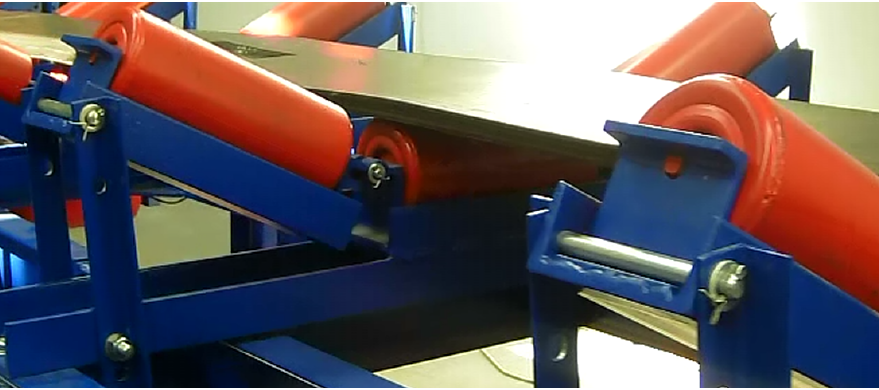
Figure 22. A Visual reference for hotspot localization.